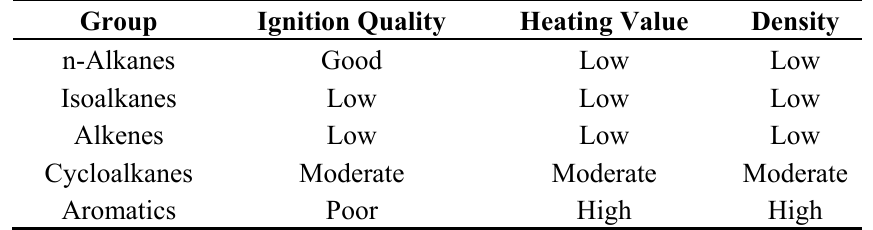
Table 3. Properties of various chemical groups and their effect on diesel properties